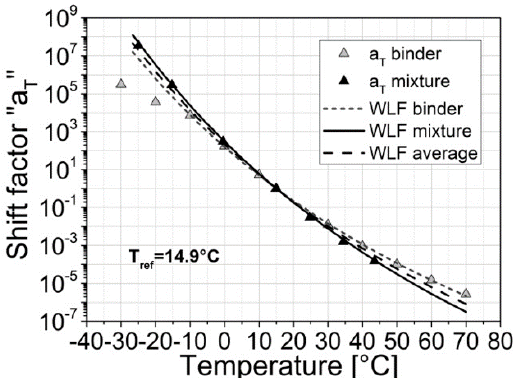
Figure 16. Shift factor aT for the GB5  mixture and its binder and comparison with the WLF equation